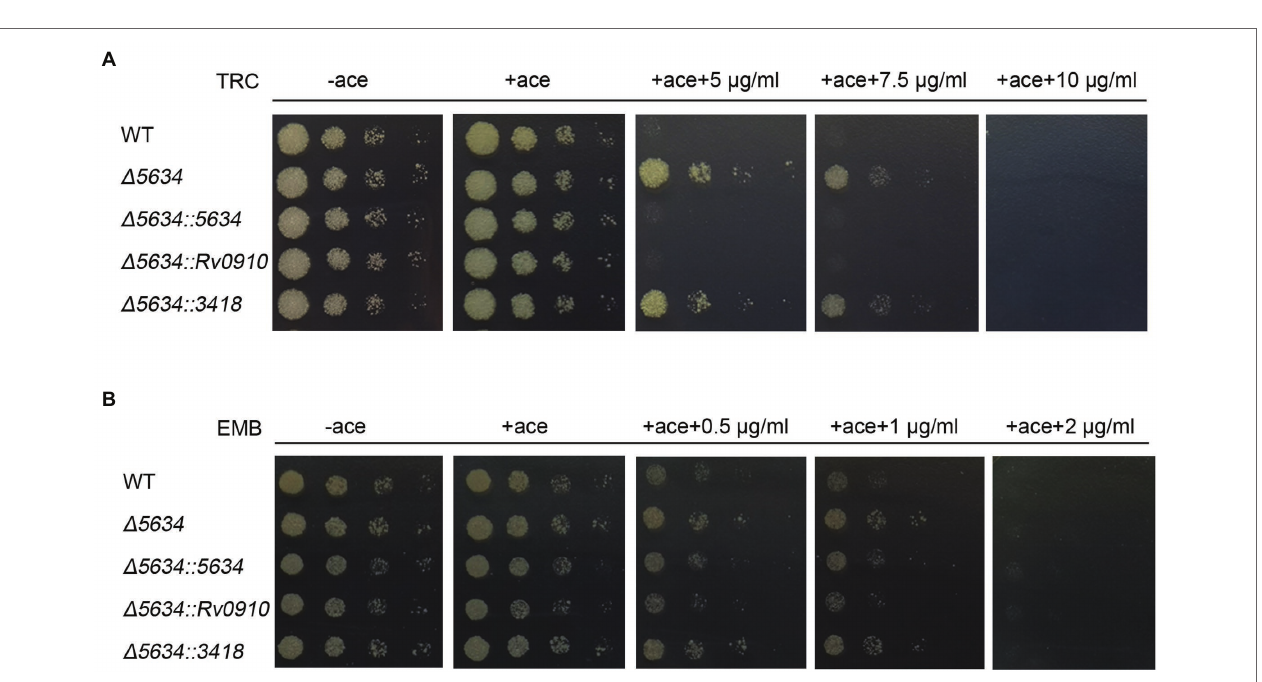
FIGURE 7 | MSMEG_5634 deletion decreases sensitivity to triclosan (TRC) but not to ethambutol (EMB) in Mycobacterium smegmatis . The indicated M. smegmatis cells were serially diluted and grown on 7H10 medium with different concentrations of TRC (A) and EMB (B) . The cells untreated with drug were cultured for 48 h, and the strains treated with drug were cultured for 72 h. WT, wild-type cells containing empty pACE vector; Δ 5634 , the MSMEG_5634 -deleted cells containing empty pACE vector; and Δ 5634::5634 , Δ 5634::Rv0910 and Δ 5634::3418 are the MSMEG_5634 -deleted cells with the ectopic expression of MSMEG_5634, Rv0910, MSMEG_3418, respectively, under the control of the inducible acetamidase promoter in pACE vector in the presence of acetamide (ace,